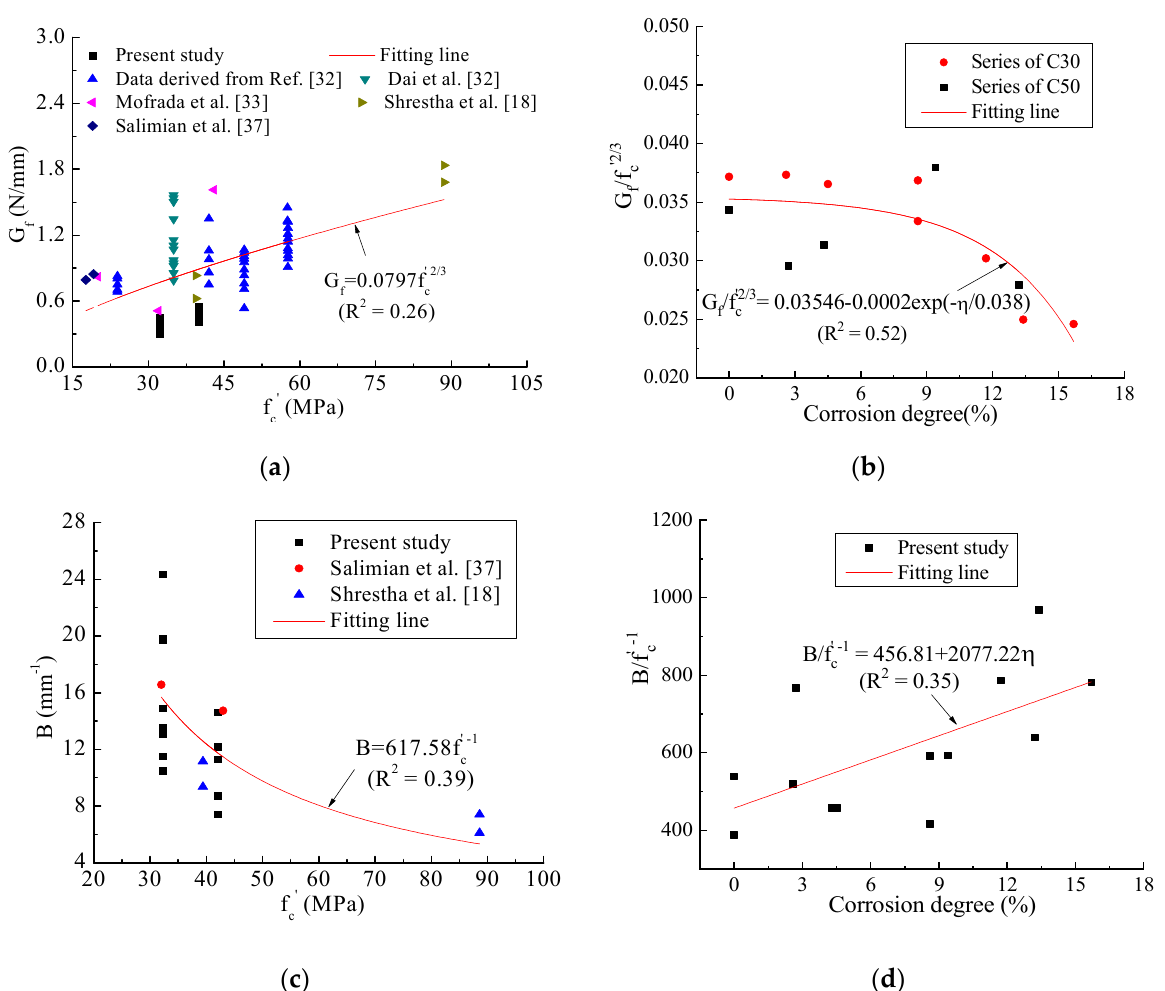
Figure 9. Combined effect of concrete strength and corrosion on G f and B . ( a ) (modified from Dai et al. [23]) Effect of concrete strength on G f [18,32,33,37]; ( b ) Combined effect of concrete strength and corrosion degree on G f ; ( c ) Effect of concrete strength on B [18,37]; ( d ) Combined effect of concrete strength and corrosion degree on B .